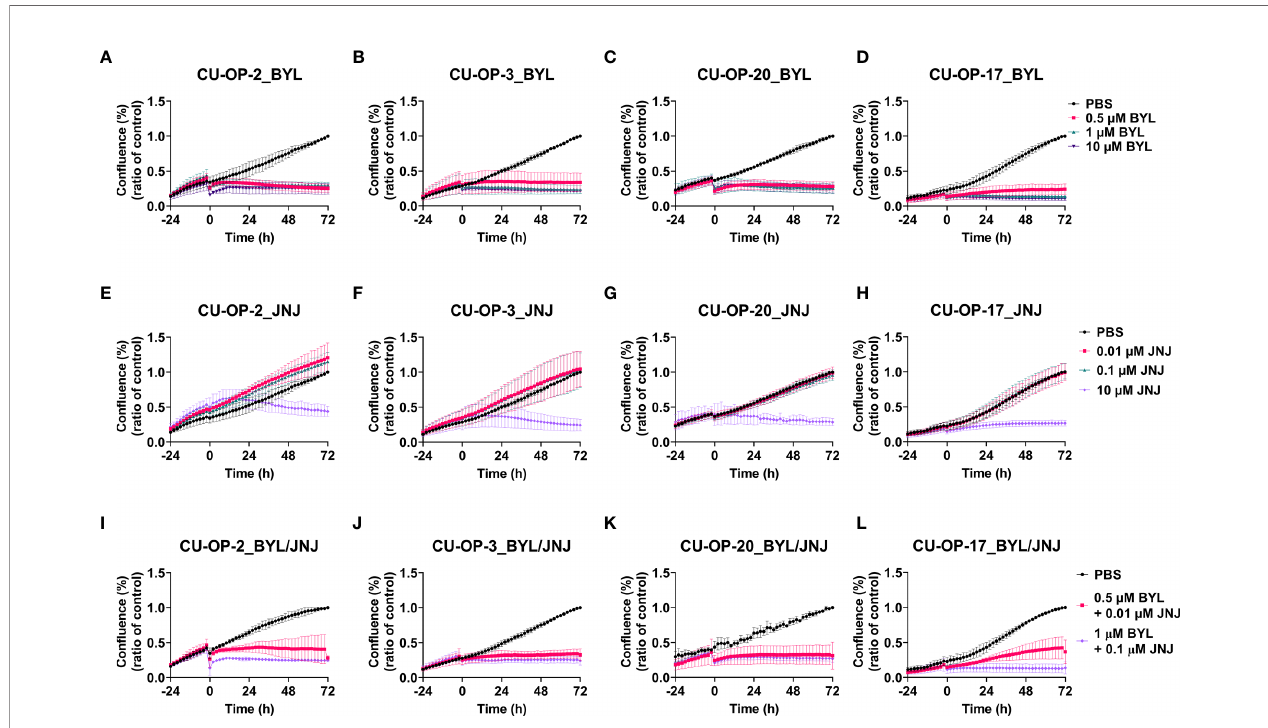
FIGURE 6 | Proliferation response of HPV + CU-OP-2, -3, -20 and HPV - CU-OP-17 cell lines upon treatment with BYL719 and JNJ-42756493. Proliferation responses of HPV + CU-OP-2, -3, -20 and HPV- CU-OP-17 after treatment with PI3K and FGFR inhibitors, BYL719 (A – D) ; and JNJ-42756493 (E – H) ; and combinational treatment with BYL719 and JNJ-42756493 (I – L) . The graphs represent three experimental runs per cell line. Con fl uence (%) denotes proliferation response; BYL denotes BYL719; JNJ denotes JNJ-42756493; CP denotes cisplatin; and DOCE denotes